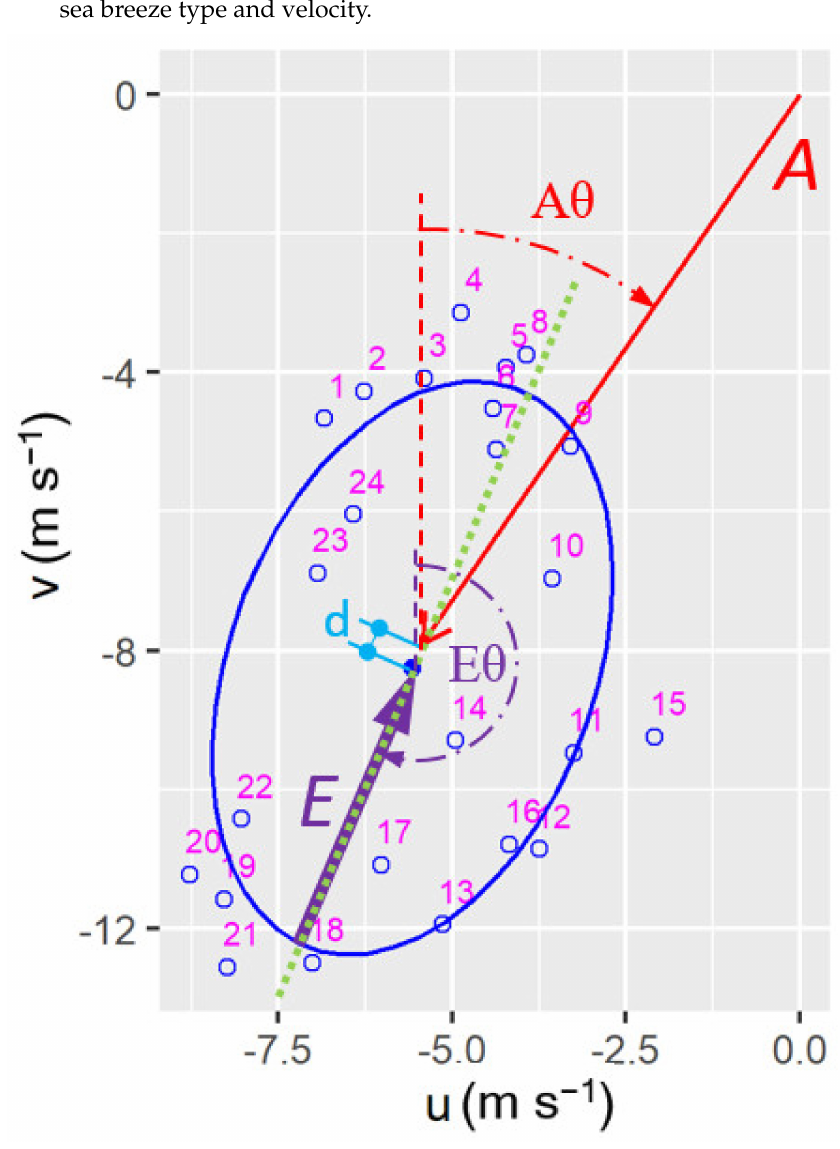
Figure 5. An ellipse example (on 15 September 2019); The red solid line with an Italic A denotes the average wind vector. Its meteorological direction is A θ . The blue solid line denotes a fitted ellipse. The purple solid line with an Italic E denotes the semi-major axis with a meteorological direction (E θ ). The distance between the arrowhead of A and the center of the ellipse (the blue dot) is denoted by d in sky-blue. Blue circles under magenta digits denote hourly mean wind vectors of the local